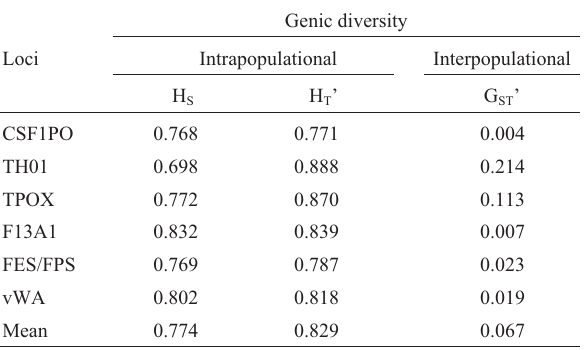
Table 3 - Estimators of variability according to Nei’s methodology (1987).